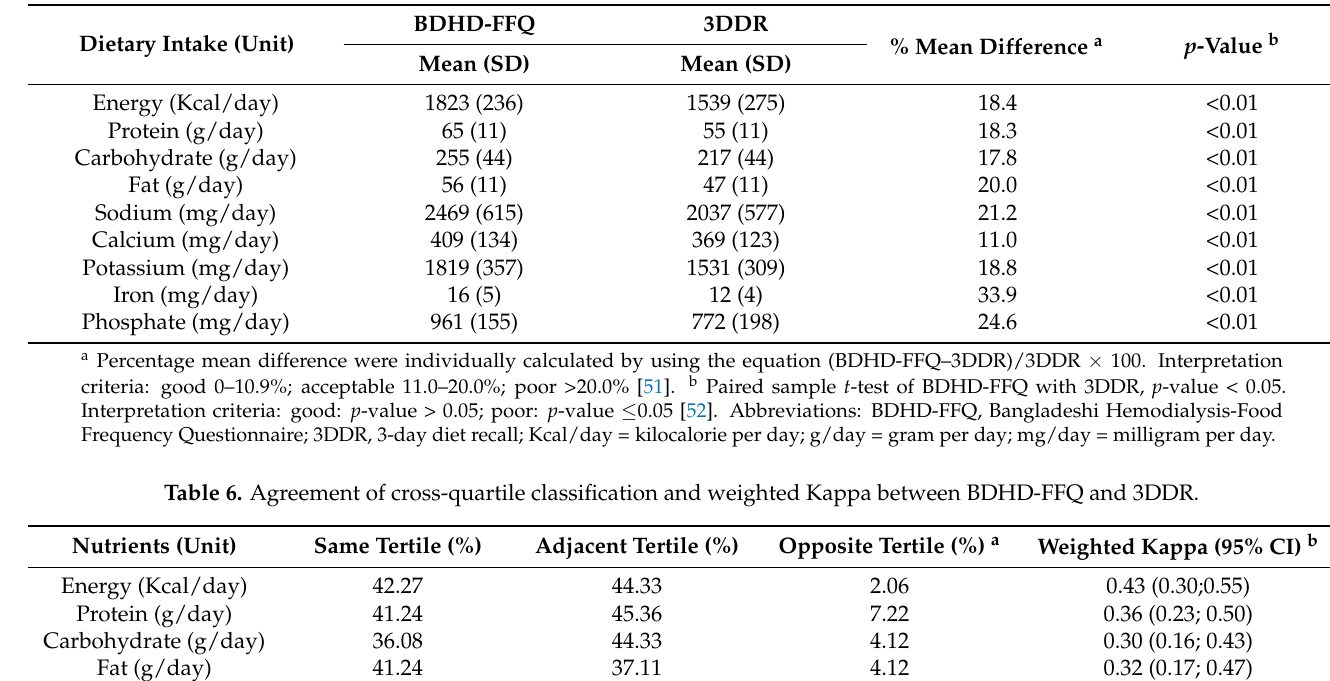
Table 5. Mean dietary nutrient consumption and mean difference between BDHD-FFQ and 3DDR.